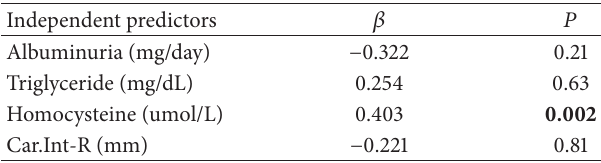
Table 5: Multiple regression analysis results in MVD